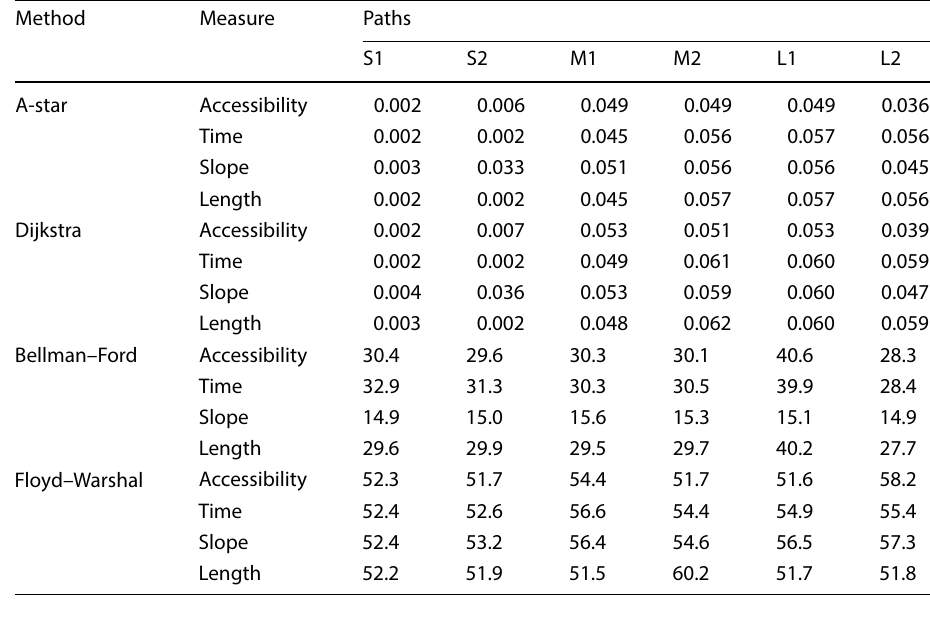
Table 4 Obtained results in execution time (in seconds) in average for all paths and methods